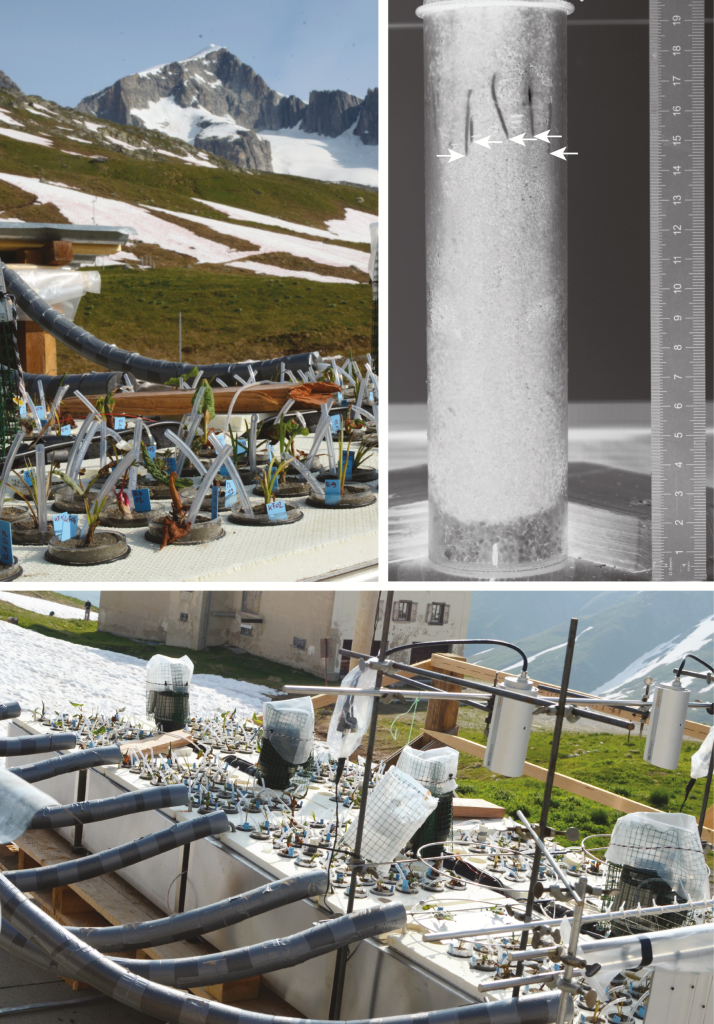
Thermostated water bath systems at the Furka Pass (2440 m a.s.l.) with transparent cylinders for root observation (measurements of RERs). The black to white converted image of a root cylinder taken in a photo box shows roots of Rumex alpinus growing along the wall. White arrows point at root tip positions.